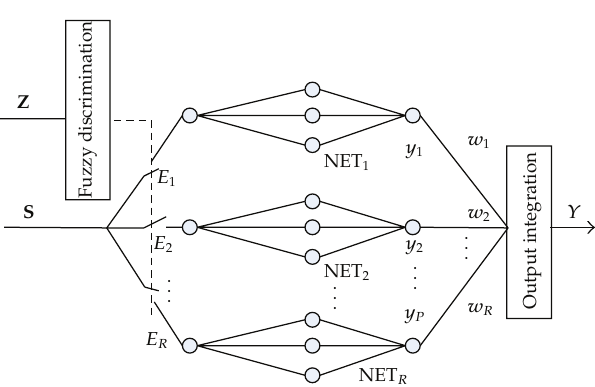
Figure 4: Modular neural network